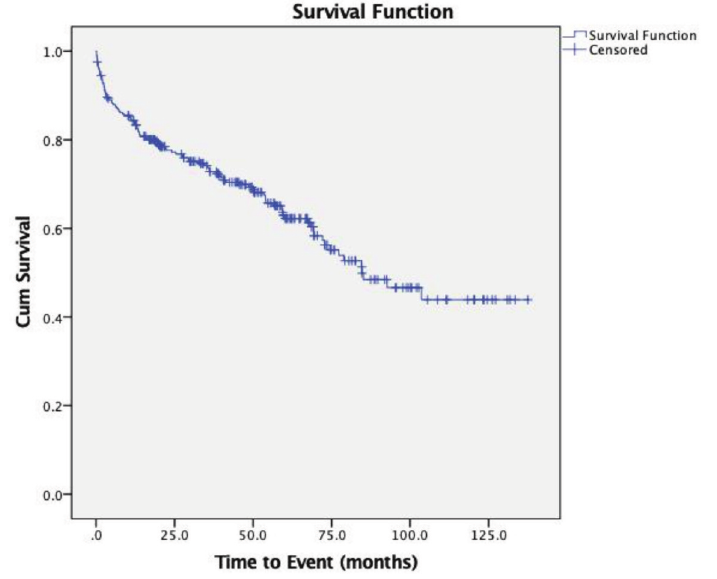
Kaplan Meier curve for overall survival estimates among THR patients Fig. 1: